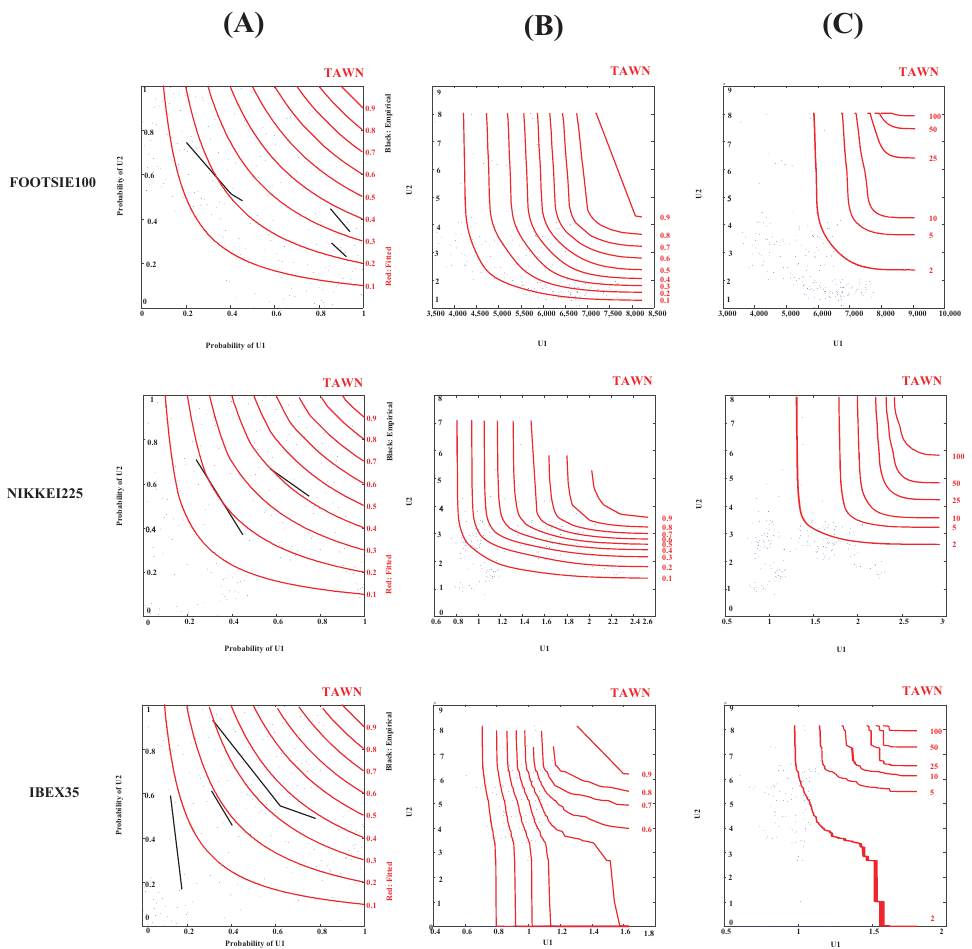
Figure 3. Probability isolines of Tawn’s copula for FOOTSIE100, NIKKEI225, and IBEX35 indices. Source: Own